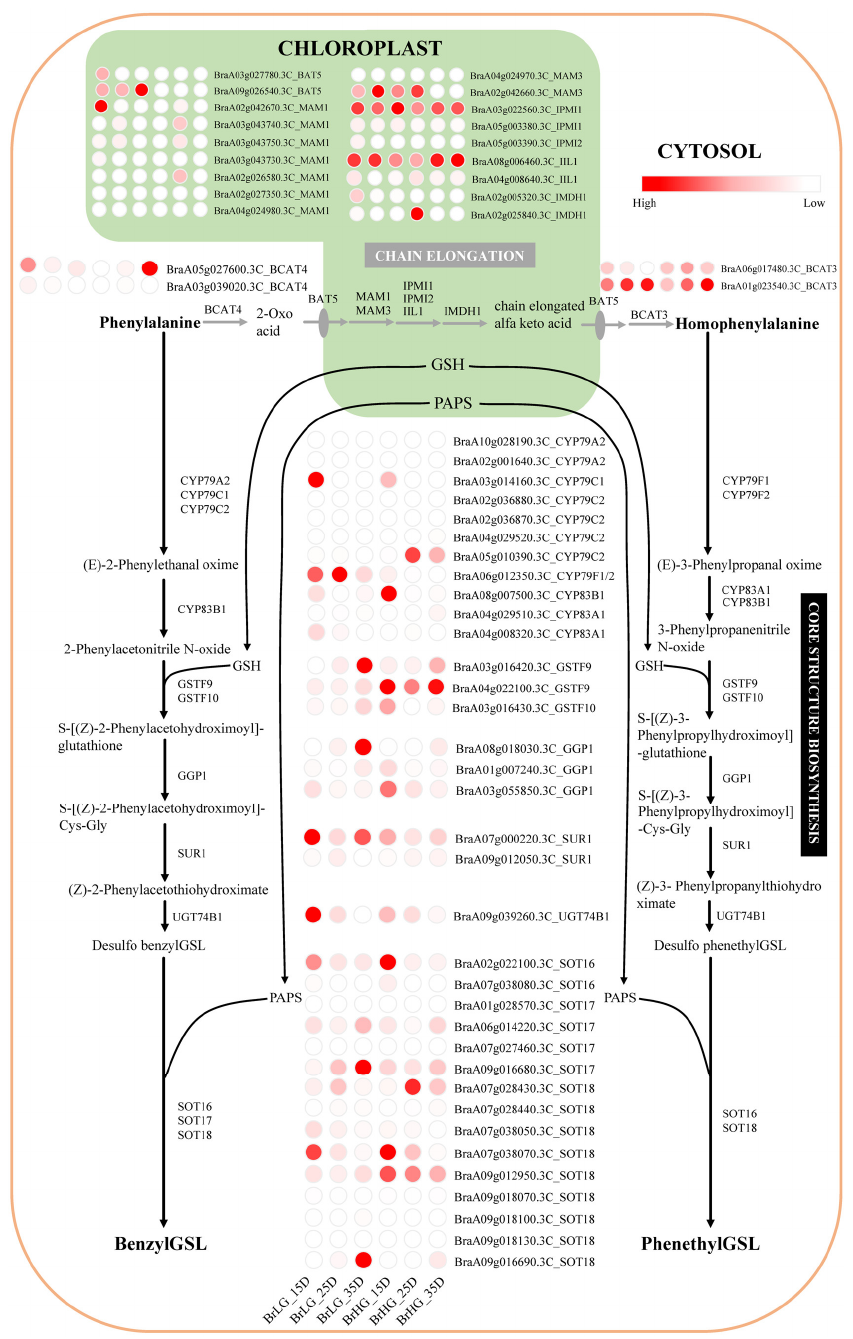
Figure 3. The proposed biosynthetic pathways of benzylGSL and phenethylGSL in B. rapa . The pro- posed pathways are based on the biochemical literatures [2,6,9,11,25]. The enzyme abbreviations